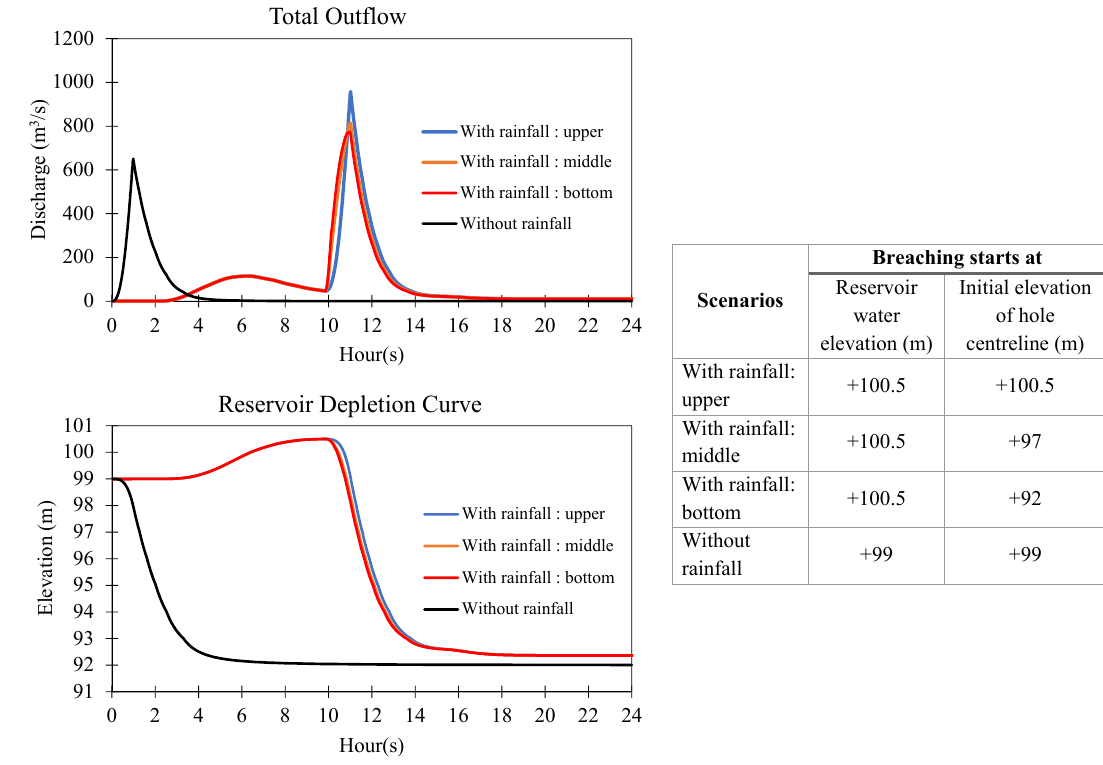
Figure 14. Total flow hydrographs and reservoir depletion curve: with and without rainfall.